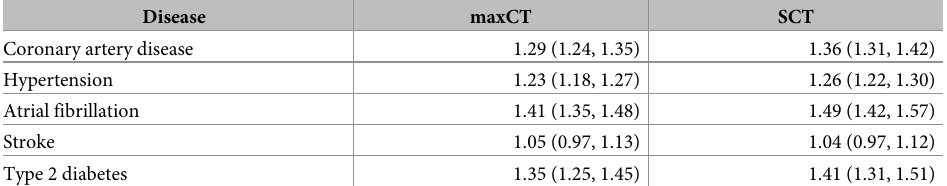
Table 6. Odds ratio (and 95% confidence interval) per standard deviation for PRSs generated by maxCT and SCT.